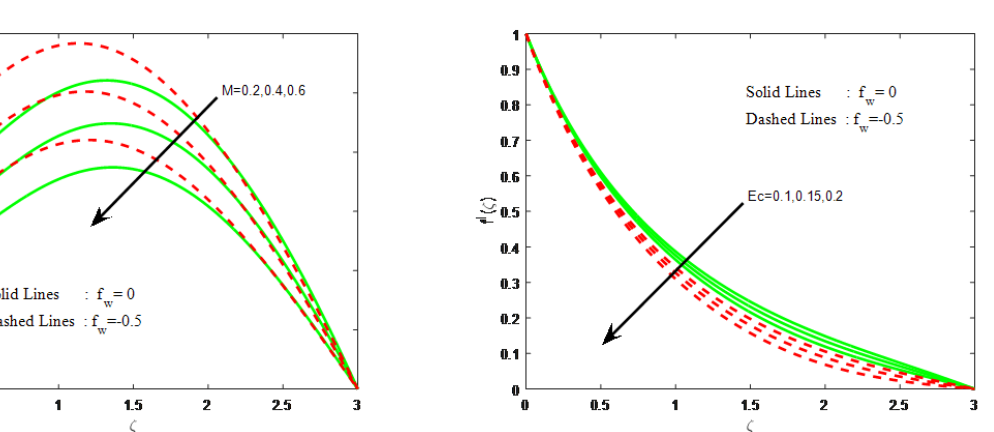
Fig. 3: The effect of Magnetic field M on temperature field